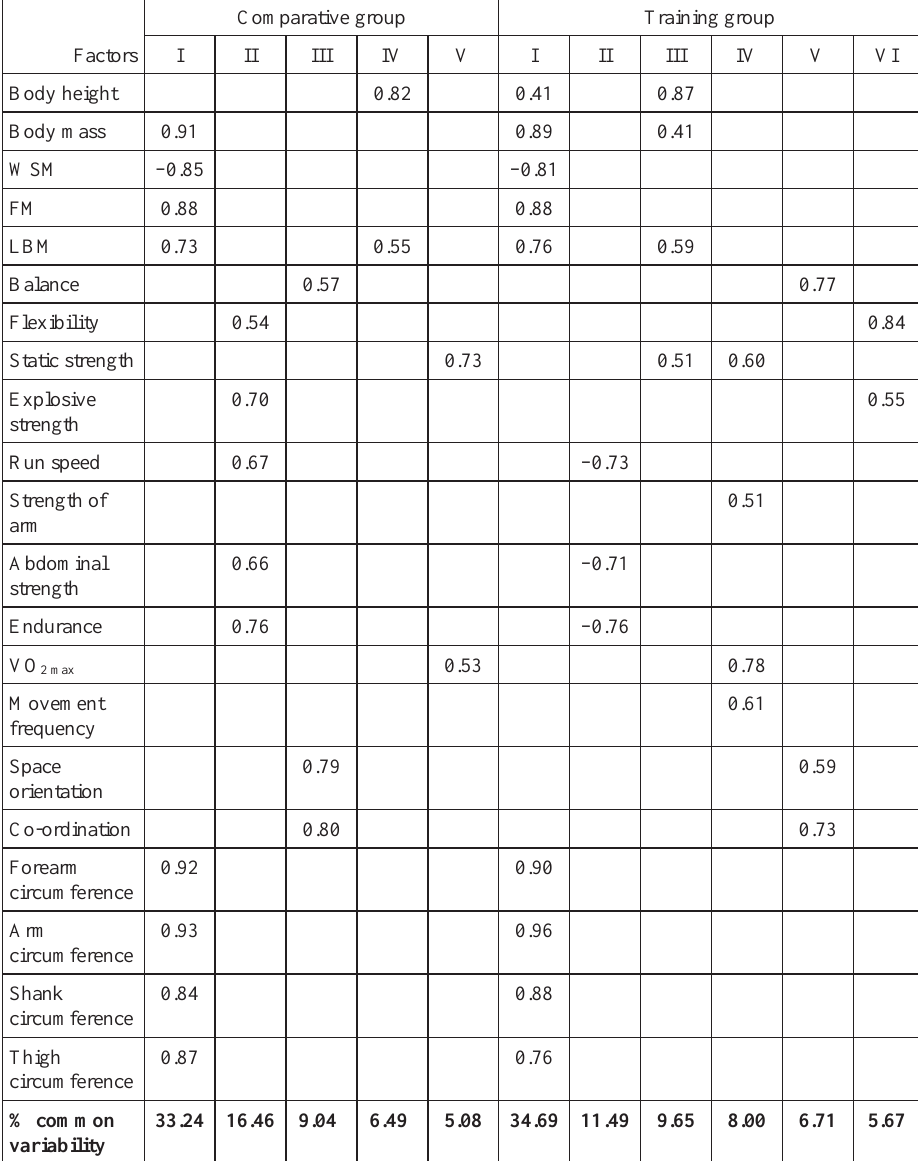
Table 7. The results of the factor analysis in the rese- arch